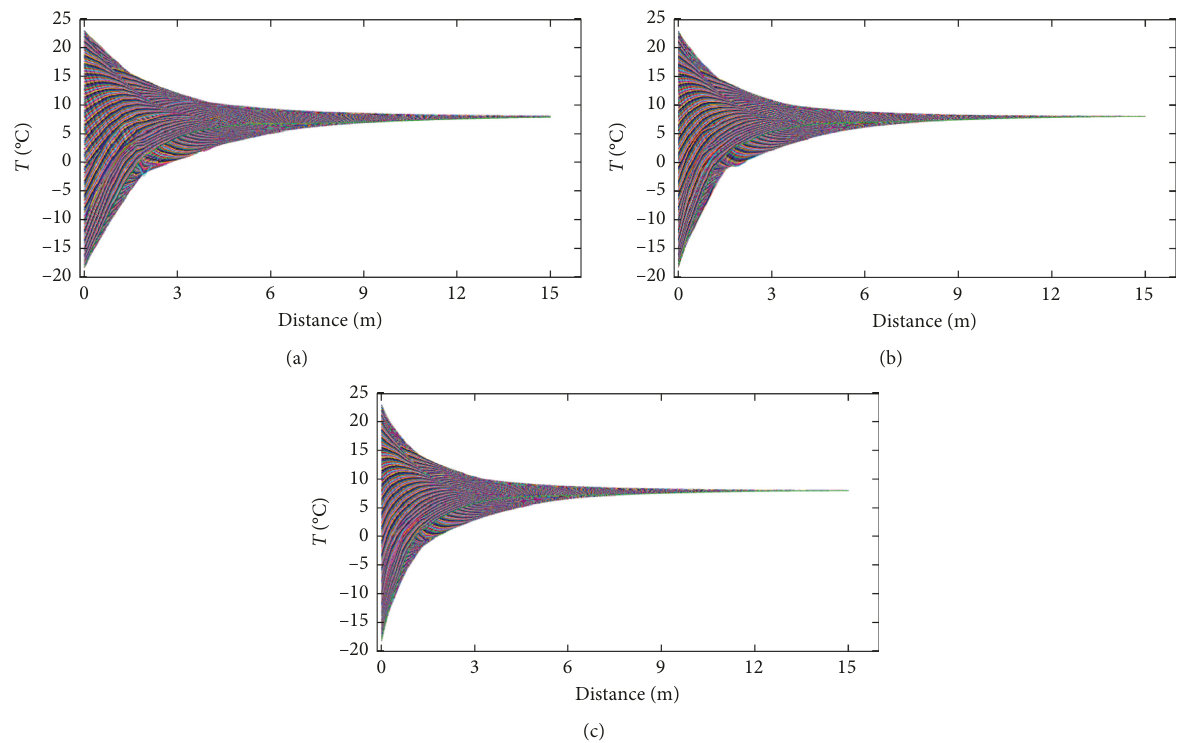
Figure 5: Maximum frozen depth at different locations: (a) slope top; (b) slope waist; (c) slope